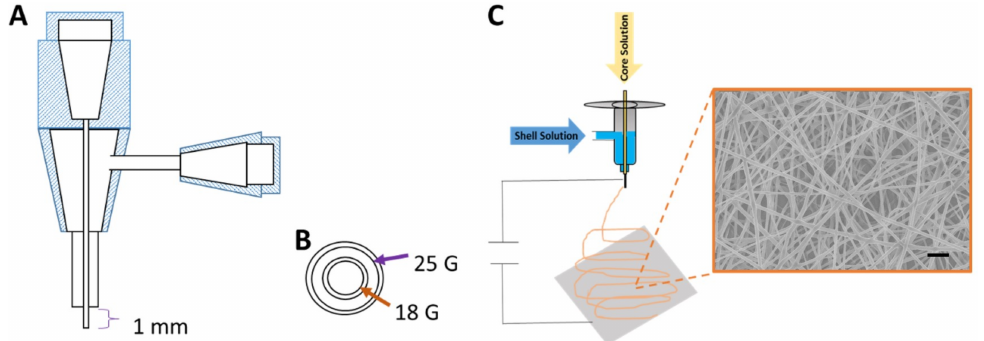
Figure 1. Schematic showing core/shell electrospinning spinneret. ( A ) Side view of spinneret, ( B ) Top-down of co-axial needles. Inner gauge size (orange) and outer gauge size (purple), ( C ) Electrospinning setup with SEM image of resulting core/shell nanofibers. Scale, 2 µ